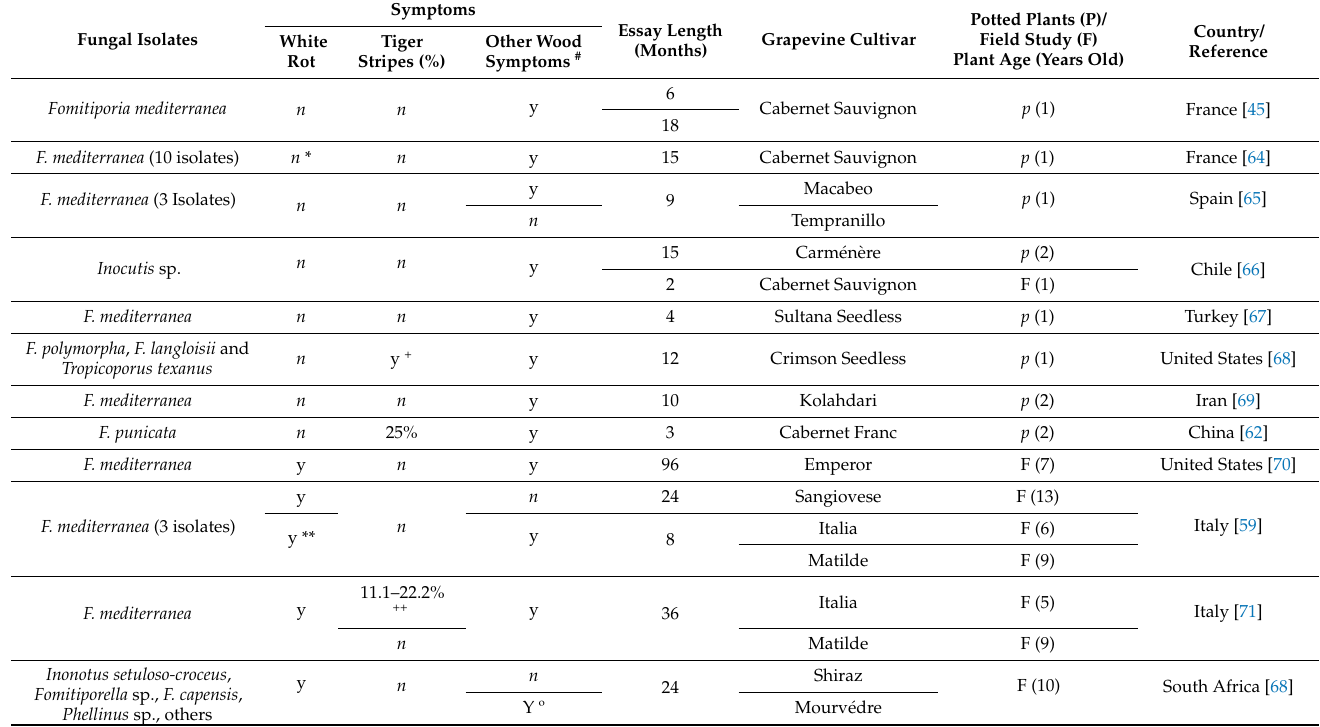
Table 1. Artificial inoculation of Hymenochaetales in potted vines or in field studies and induction of wood and leaf symptomatology.